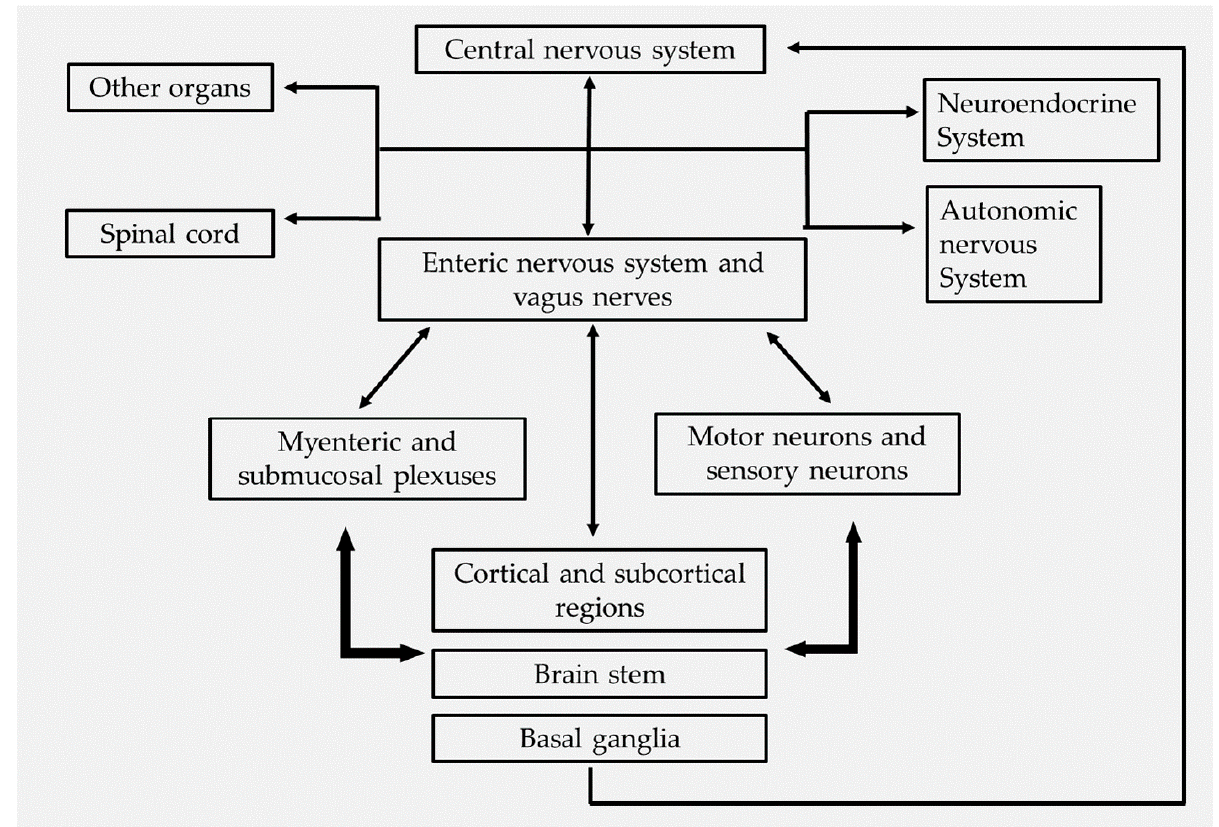
Figure 2. Bidirectional communication and the mediators of the gut–brain axis.